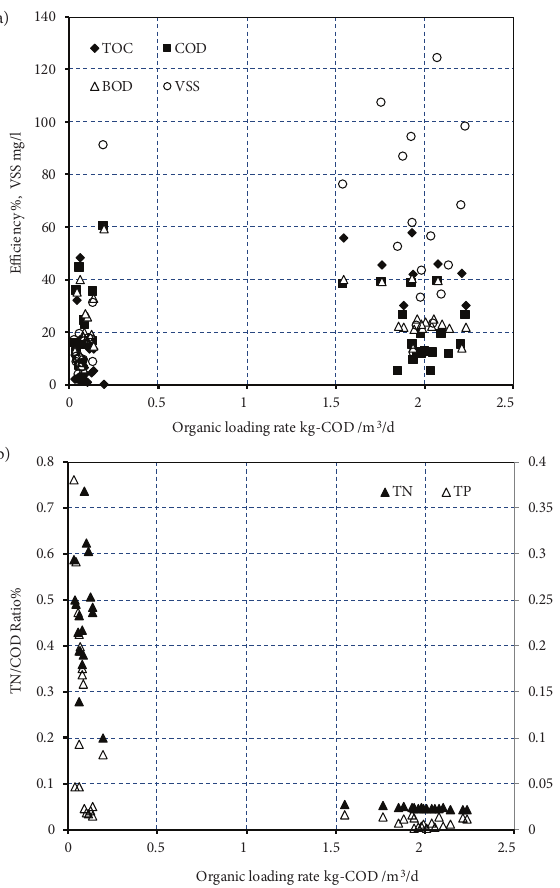
Figure 5. Hybrid biological reactor performance under high flow-high oxygen scenario: a) organics removal efficiency and VSS concentration versus organic loading rate; b) TN/COD, TP/COD, versus organic loading